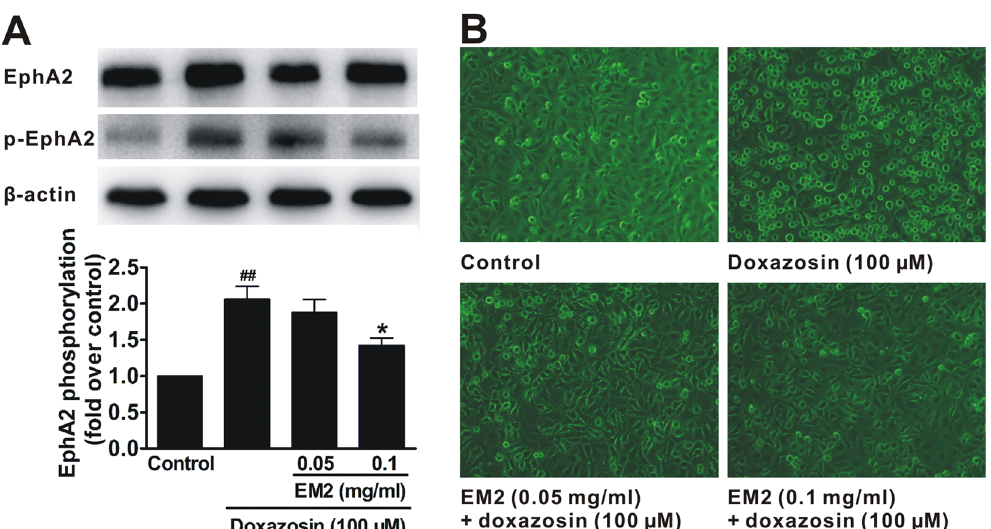
Figure 7. EM2 reduces EphA2 phosphorylation and the cell rounding caused by the agonist. ( A ) The protein level of p-EphA2 (phosphorylated EphA2). Representative western blotting analysis and the quantifications are shown on the top and bottom, respectively. Data are presented as means ± S.E.M. (n = 3). ## p < 0.01 compared with control group. * p < 0.05 compared with doxazosin (agonist group). ( B ) Representative photographs of the morphological changes in PC3